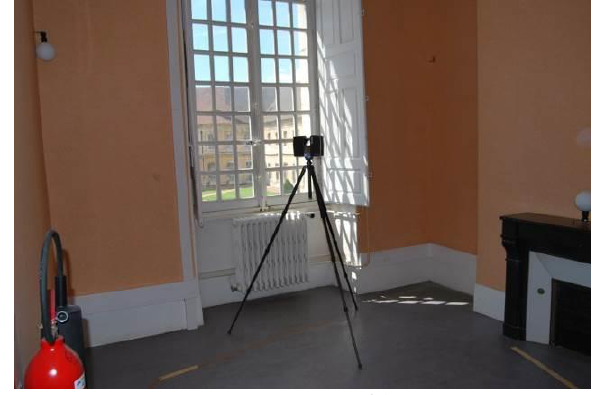
Figure 1. Digitization of the room